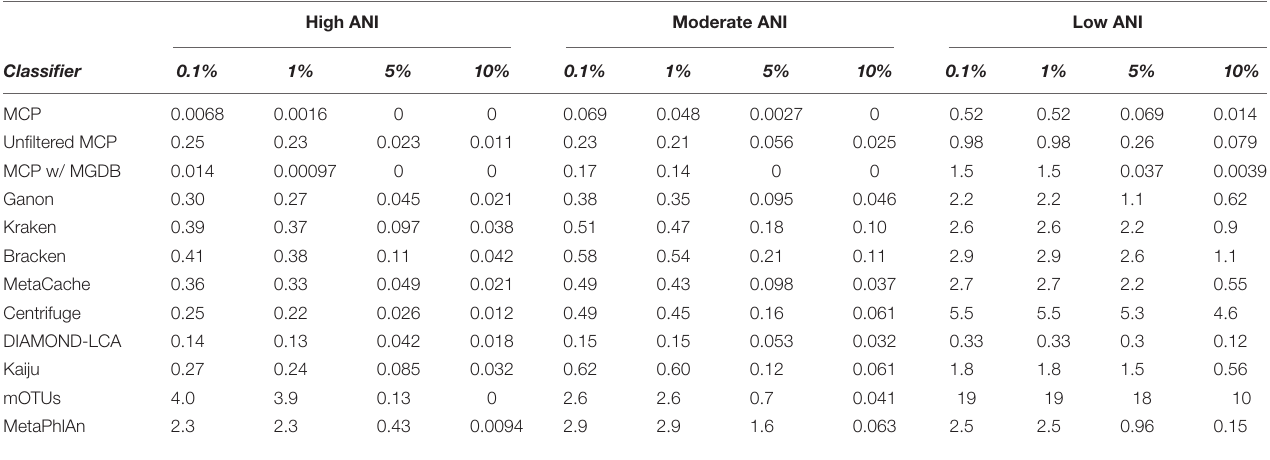
TABLE 3 | Mean detection limit of classifiers at select false detection